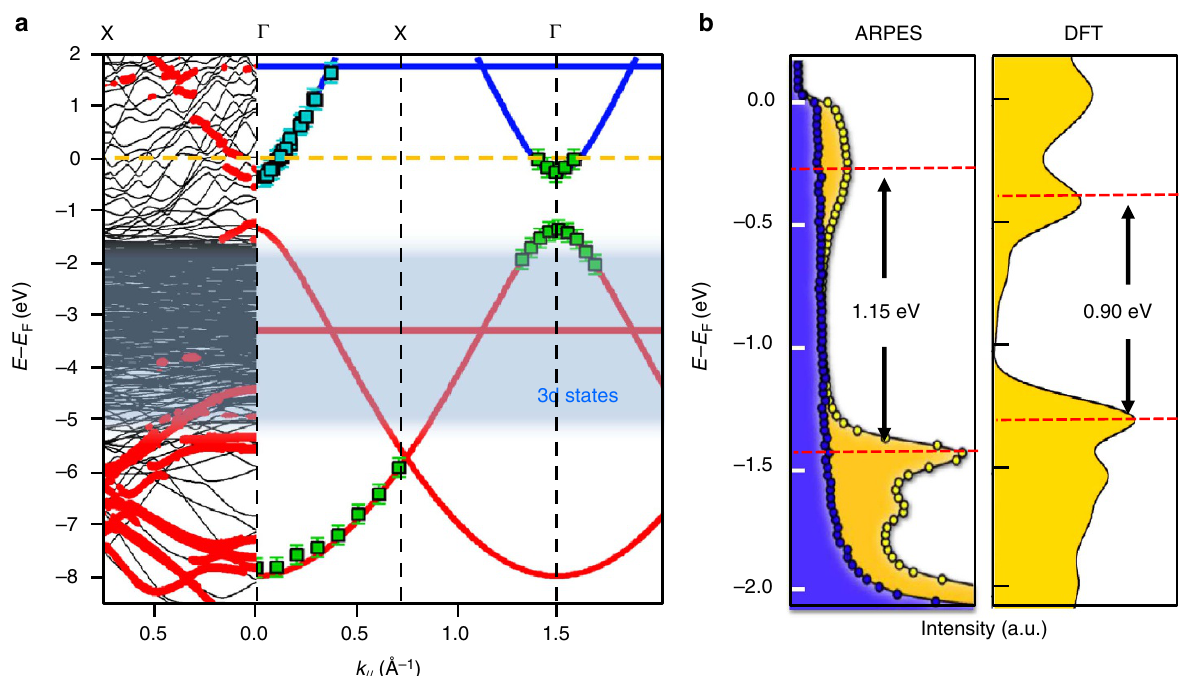
Figure 4 | Band-structure of PPP polymers grown on Cu(110). ( a ) DFT band structure (black lines, red circles correspond to the projection on the molecular layer), tight-binding modelling (red and blue solid lines), ARPES (green squares) and STS (blue squares) experimental dispersion curves. The absolute positions of the valence and conduction bands in the tight-binding model have been independently shifted towards the occupied states by 0.1 and 1.9eV, respectively. ( b ) k -integrated photoemission DOS on the Cu(110) substrate (left panel, blue), on PPP/Cu(110) (left panel, yellow) and corresponding DFT DOS (right panel,